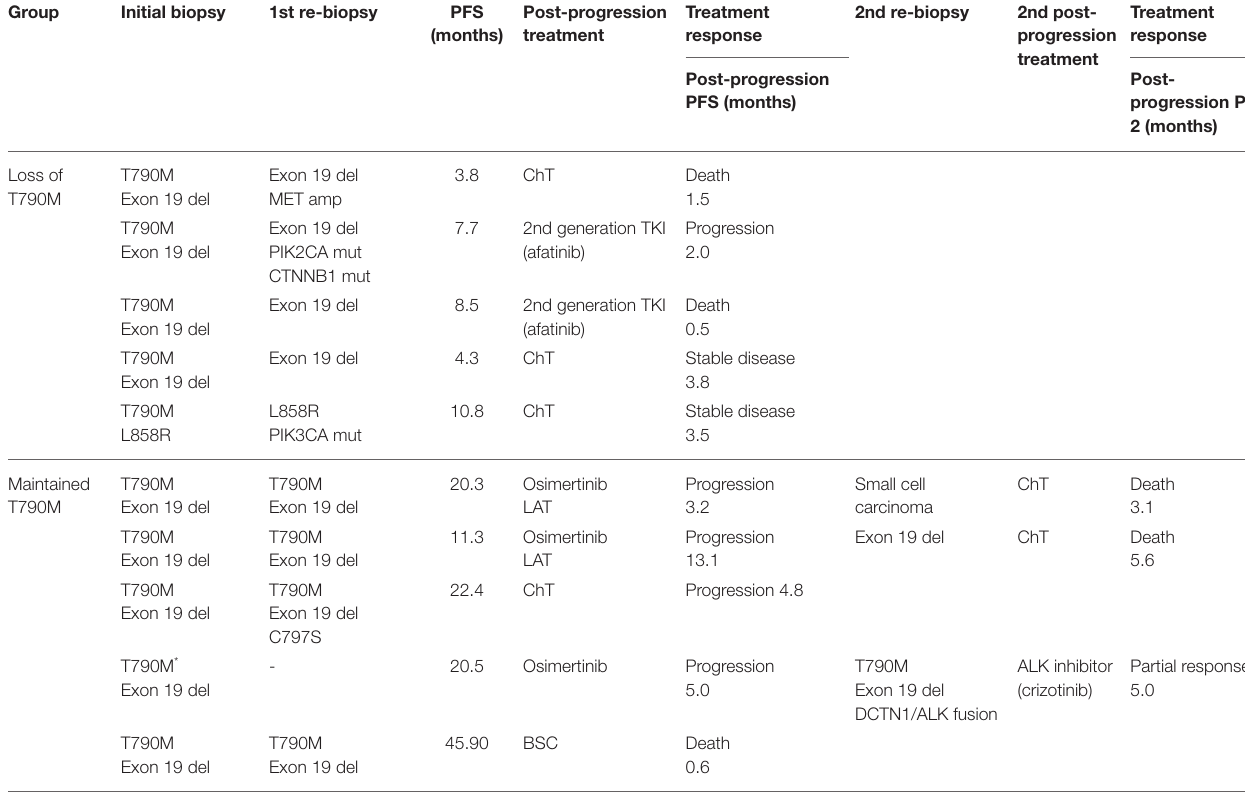
TABLE 2 | Resistance profile of osimertinib. Group Initial